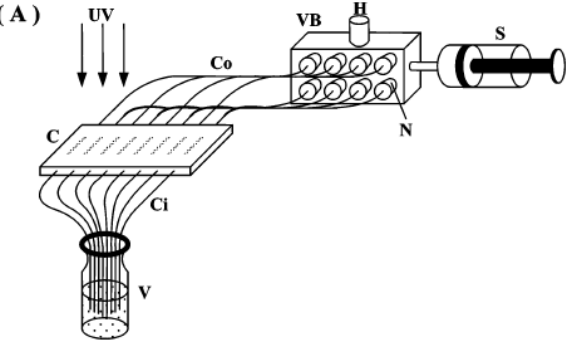
Figure 14. Experimental setup for the polymerization preparation of monolith: S, 10-mL plastic syringe; N, nanoports; VB, vacuum distribution box; H, vent hole; C, polymer substrate chip; Ci, Co, inlet/outlet connecting capillaries; UV, UV light; V, vial containing monomer mixture [146]. Reprinted with permission from the American Chemical